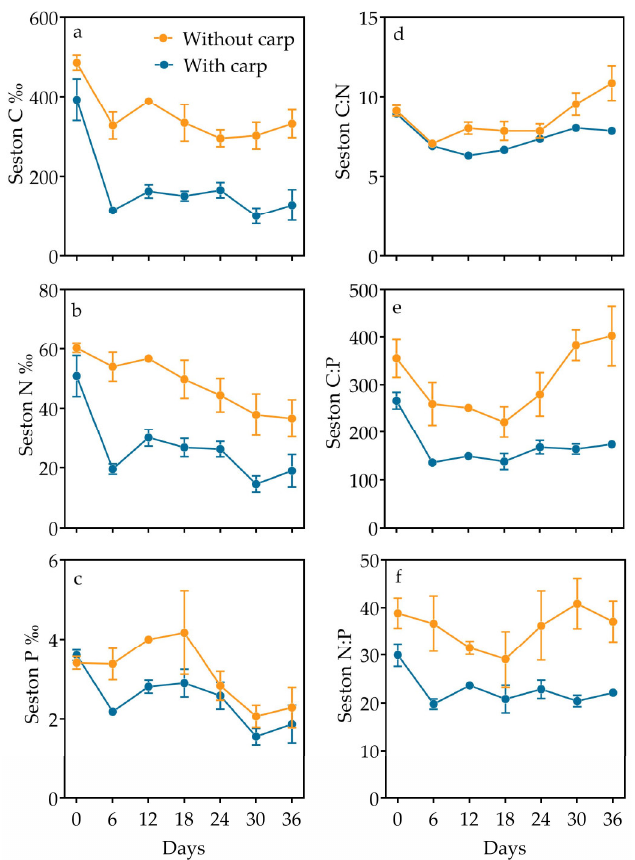
Figure 7. Comparisons of C, N, P contents ( a – c ) and molar ratios of ( d ) carbon to phosphorus (C/P), ( e ) carbon to nitrogen (C/N), and ( f ) nitrogen to phosphorus (N/P) in suspended particulate matter (SPM) between the fish-present and -absent treatments. Values denote mean ± SE ( n = 3).